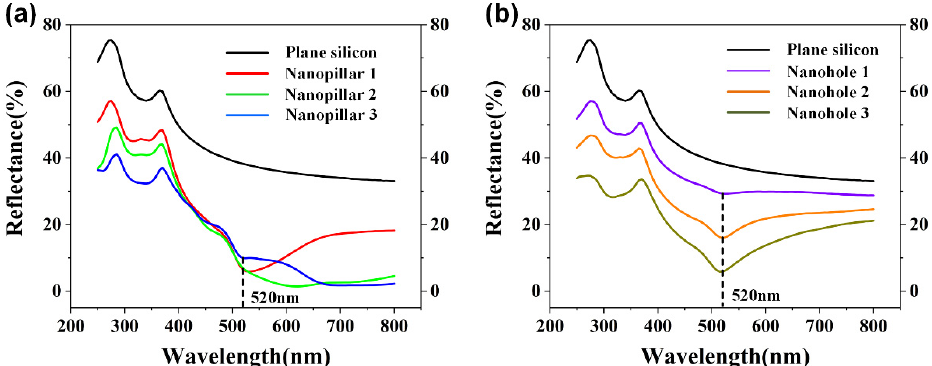
Figure 4. Reflection curves of ( a ) plane silicon and three different sizes for nanopillars samples; ( b ) plane silicon and three different sizes for nanoholes samples.